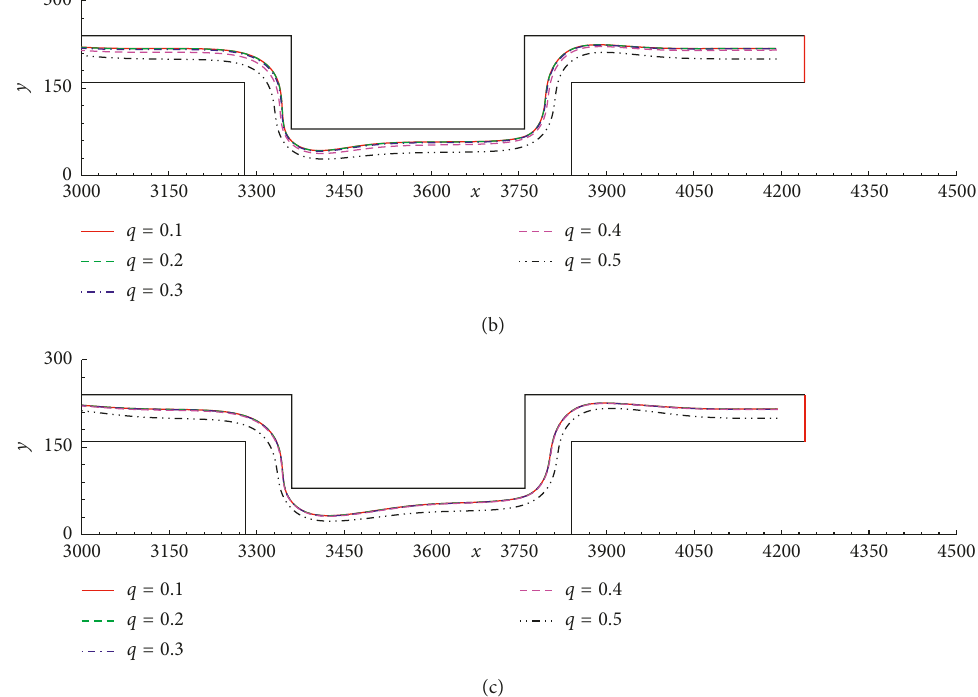
Figure 5: The effect of q on particle trajectories: (a) Re